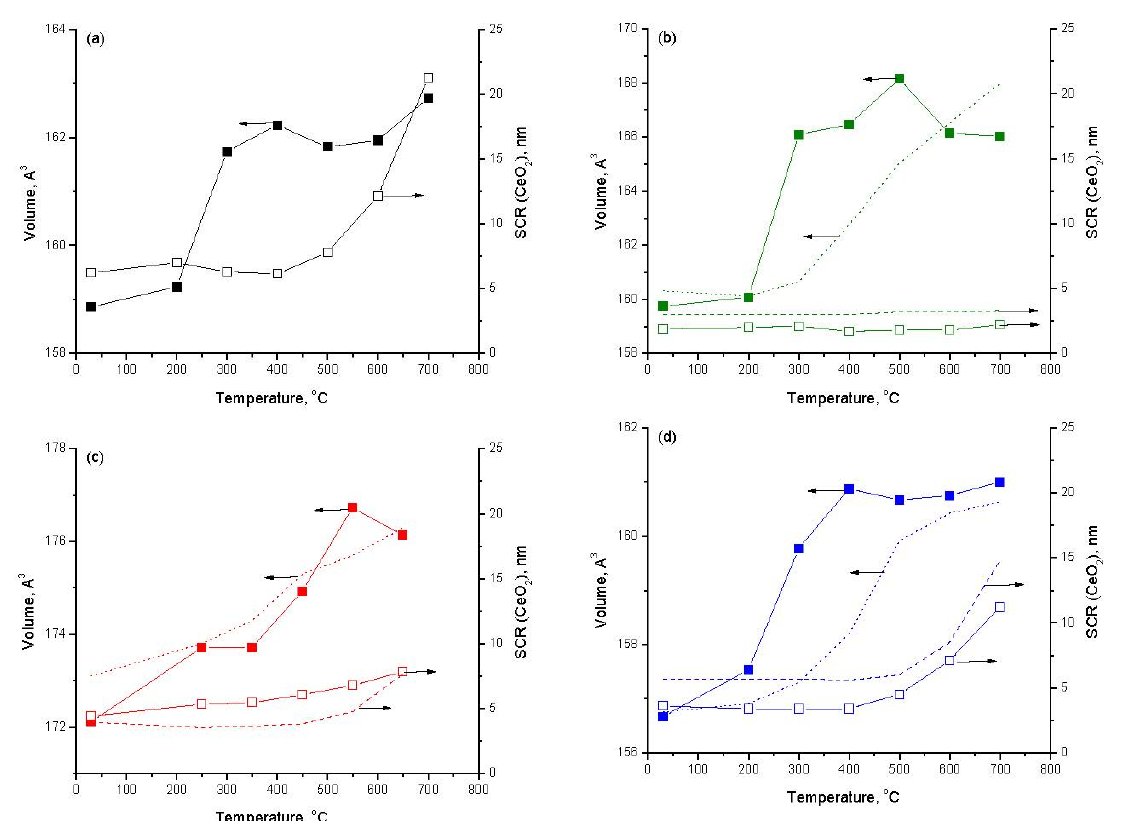
Figure 13. Evolution of the unit cell volume and CSR of CeO 2 -based solid solution during the reduction of (CeM) 1 − x Ni x O y samples. ( a ) Ce 0.8 Ni 0.2 O 1.8 ; ( b ) Ce 0.4 Al 0.4 Ni 0.2 O 1.6 , Ce 0.5 Al 0.5 O 1.75 ; ( c ) Ce 0.4 La 0.4 Ni 0.2 O 1.6 , Ce 0.5 La 0.5 O 1.75 ; ( d ) Ce 0.4 Mg 0.4 Ni 0.2 O 1.4 , Ce 0.5 Mg 0.5 O 1.5 . Dash and dot lines refer to nickel-free samples. The XRD data for (CeM) 1 − x Ni x O y samples after activation at 800 °C for 1 h in a 30%H 2 /70%Ar flow is presented in Table 3 and Figure 14.